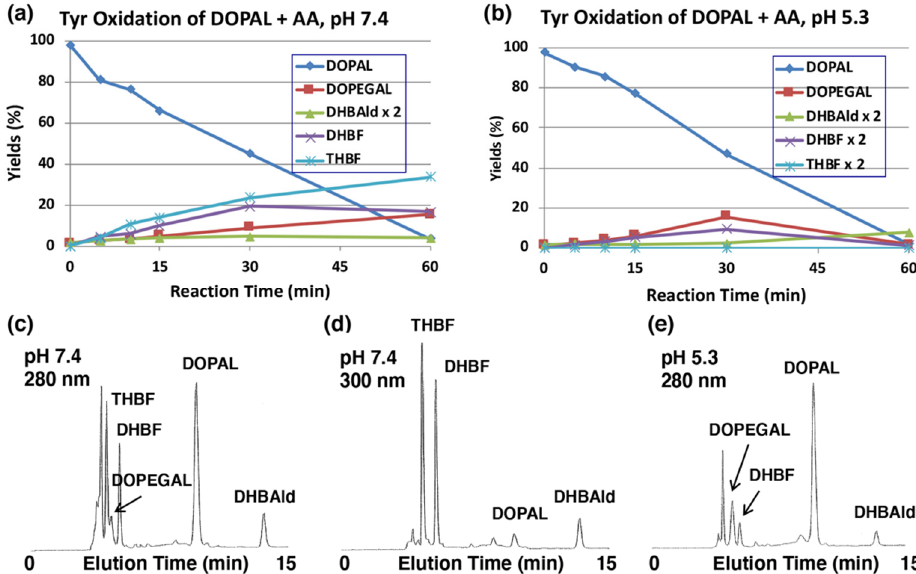
Figure 3. Time course of the tyrosinase-catalyzed oxidation of DOPAL (100 µM) in the presence of AA (1 mM). ( a ) HPLC analysis following the tyrosinase-catalyzed oxidation of DOPAL plus AA at pH 7.4 and 37 °C and ( b ) at pH 5.3 and 37 °C. ( c , d ) HPLC chromatograms of the tyrosinase-catalyzed oxidation of DOPAL plus AA at pH 7.4 after 30 min, detected at 280 nm ( c ) and at 300 nm ( d ). ( e ) pH 5.3 after 30 min, detected at 280 nm. Reaction was stopped by the addition of 0.8 M HClO 4 . Data for the HPLC analysis were obtained from averages of two independent determinations ( a , b ).